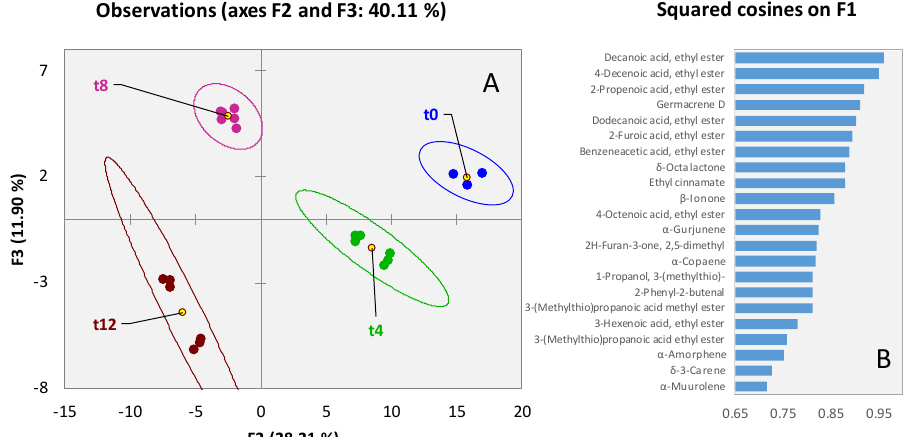
Figure 3. PCA scores plot based on normalized chromatographic areas from 125 targeted compounds across all analyzed dried pineapple samples (Figure 1A). Confidence ellipses (95% of confidence) relate to shelf-life (t0-blue; t4-green; t8-purple; t12-garnet color). The histogram in Figure 2B reports the squared cosines of the variables on PC1.